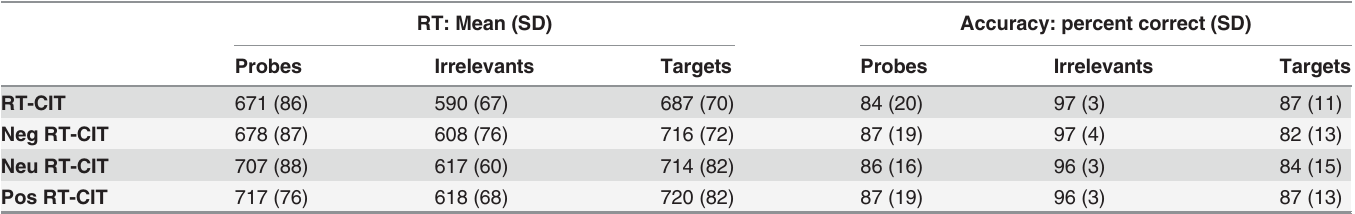
Table 1. Descriptive statistics for the mean reaction time and accuracy for the stimuli (probes, irrelevants and targets) according to the four conditions: RT-CIT, Neg RT-CIT, Neu RT-CIT, Pos